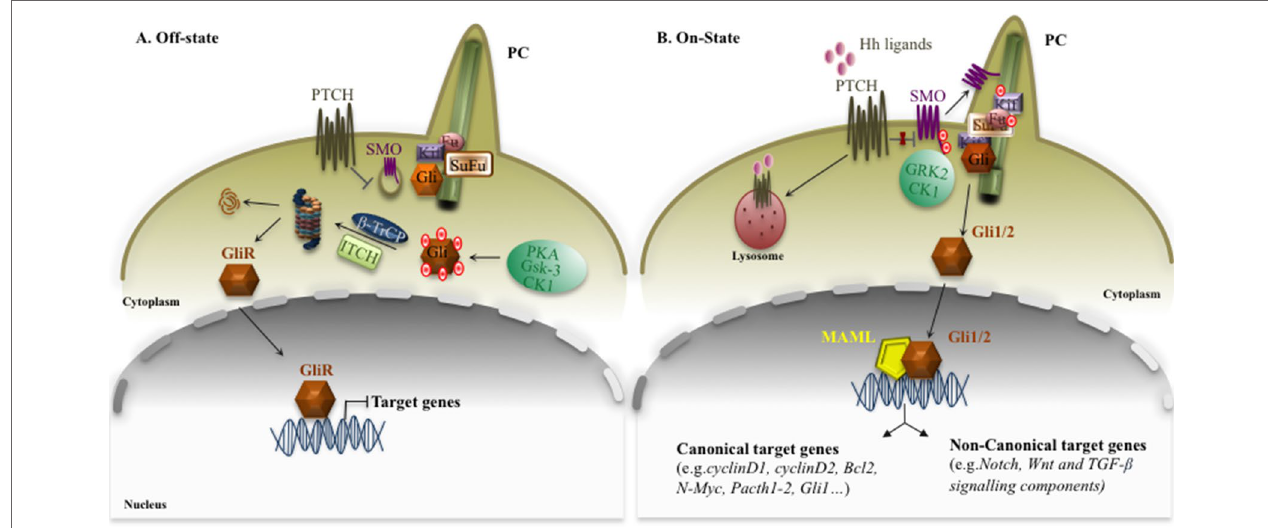
FIGURE 1 | Canonical Hh signaling. The canonical Hh signaling pathway in off (panel A ) or on (panel B ) state. The figure is widely discussed in the text. The red dots represent post-translational modifications: